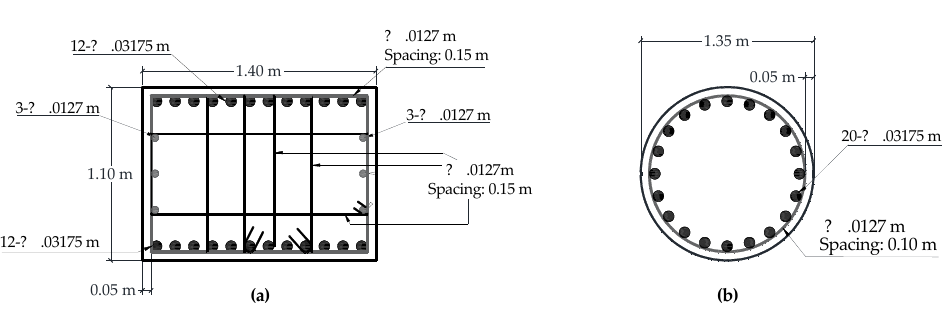
Figure 2. Cross-section view.